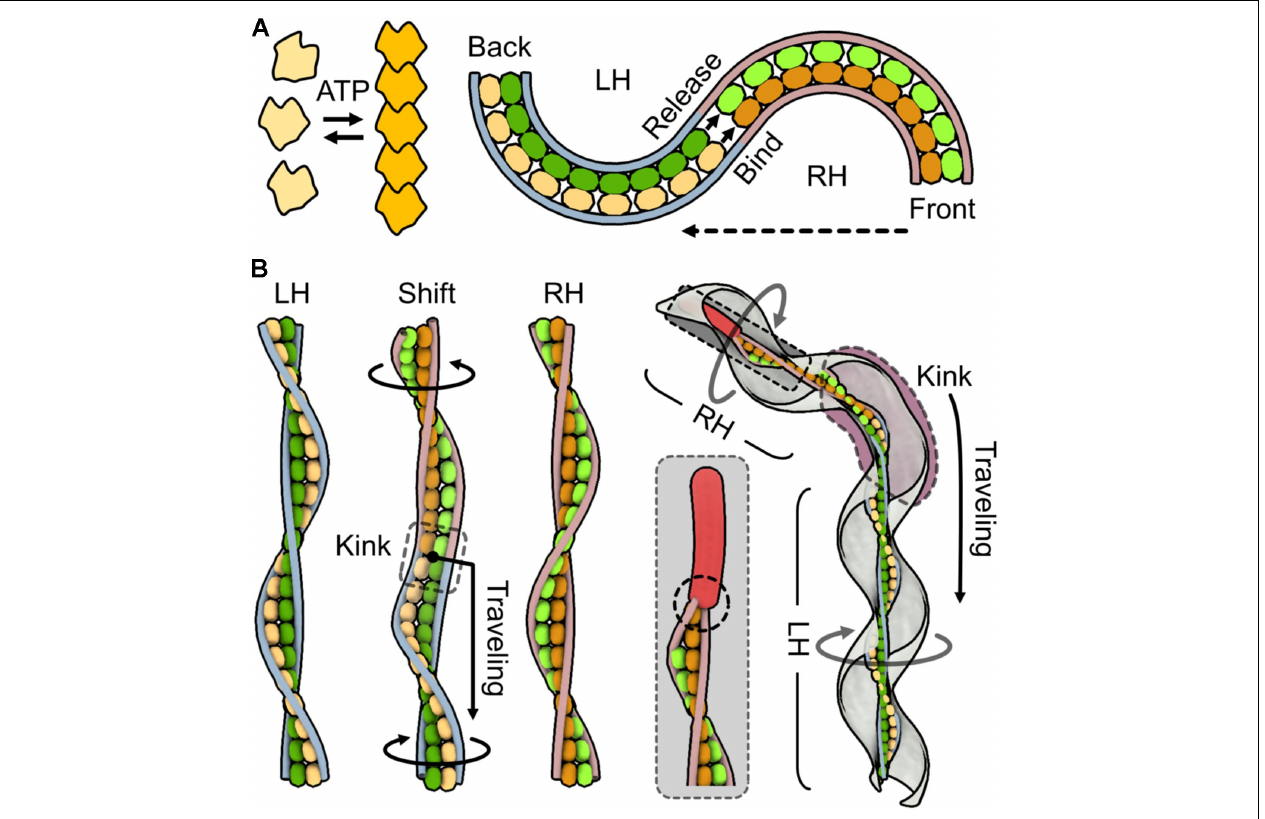
FIGURE 4 | One working model for force generation and the transmission mechanism. SMreBs are presented as free and chained molecules. Two classes of SMreBs are colored yellow (light or dark) and green (light or dark). Fibril filaments are shown as blue [left-handedness (LH)] and red [right-handedness (RH)] strings without detailed structures for simplicity. Monomeric, polymerized, dissociated, and associated SMreB molecules are colored light yellow, dark yellow, light yellow or green, and dark yellow or green, respectively. (A) Bimetallic strip action of the ribbon suggested from characters of SMreB and fibril filaments. Left: Polymerization based on ATP energy is observed in some MreBs. Right: Helicity shift caused by length changes occurring differently in individual SMreB filaments. Left-handed ribbon shifts to right-handed from the front as shown by the broken arrow. The length changes in SMreB filaments related to polymerization dynamics of MreBs cause the helicity shift. Here, contraction is simply coupled to the association of molecules, but many other scenarios can be considered. (B) Three-dimensional presentation for helicity shift originated from bimetallic strip action of SMreB filaments. For simplicity, the ribbon is presented by the central paired SMreB filaments and the peripheral two fibril filaments. Left: LH, shifting (Shift), and RH ribbons are shown. In shifting, the yellow SMreB filament is switching from extended to contracted states, and the green filament is switching in the opposite way. Helicity shift propagates from upper to lower regions. A kink observed around the shifting point travels along the ribbon axis as shown by the black arrow, through the cooperativity of the structural changes. The upper and lower parts of the ribbon rotate relative to the switching point as indicated by black circular arrows. Right: Schematic presentation of a swimming cell. The dumbbell fixes filament movements at an end as marked by a broken circle, giving directionality to the ribbon. The kink travels down along the entire cell axis as shown by the black arrow, generating the counter-rotational torques in the front and back position of the kink. It also sometimes changes its traveling direction, showing the reversibility of the conformational